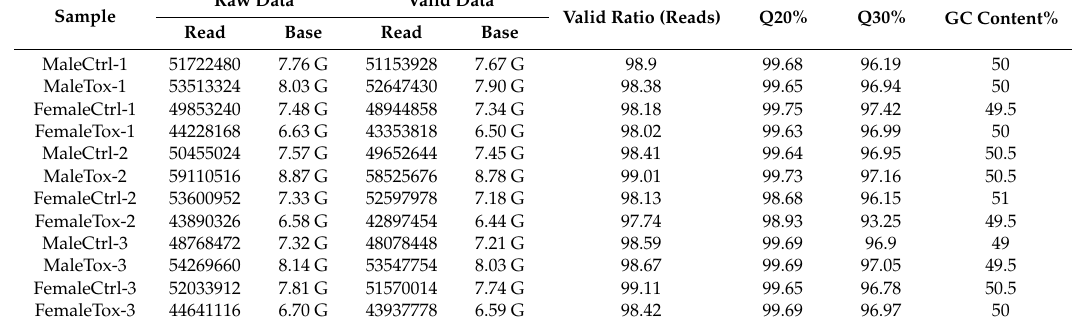
Table 2. Pretreatment results of reads data in the high throughput sequencing.